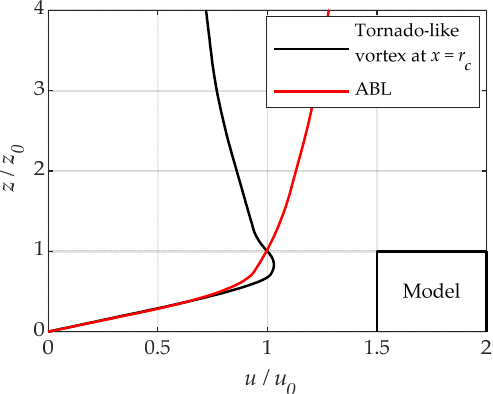
Figure 9. Normalized wind profiles of the tornado-like vortex and atmospheric boundary layer wind. The wind profile of the ABL is derived from Levitan et al. [26].